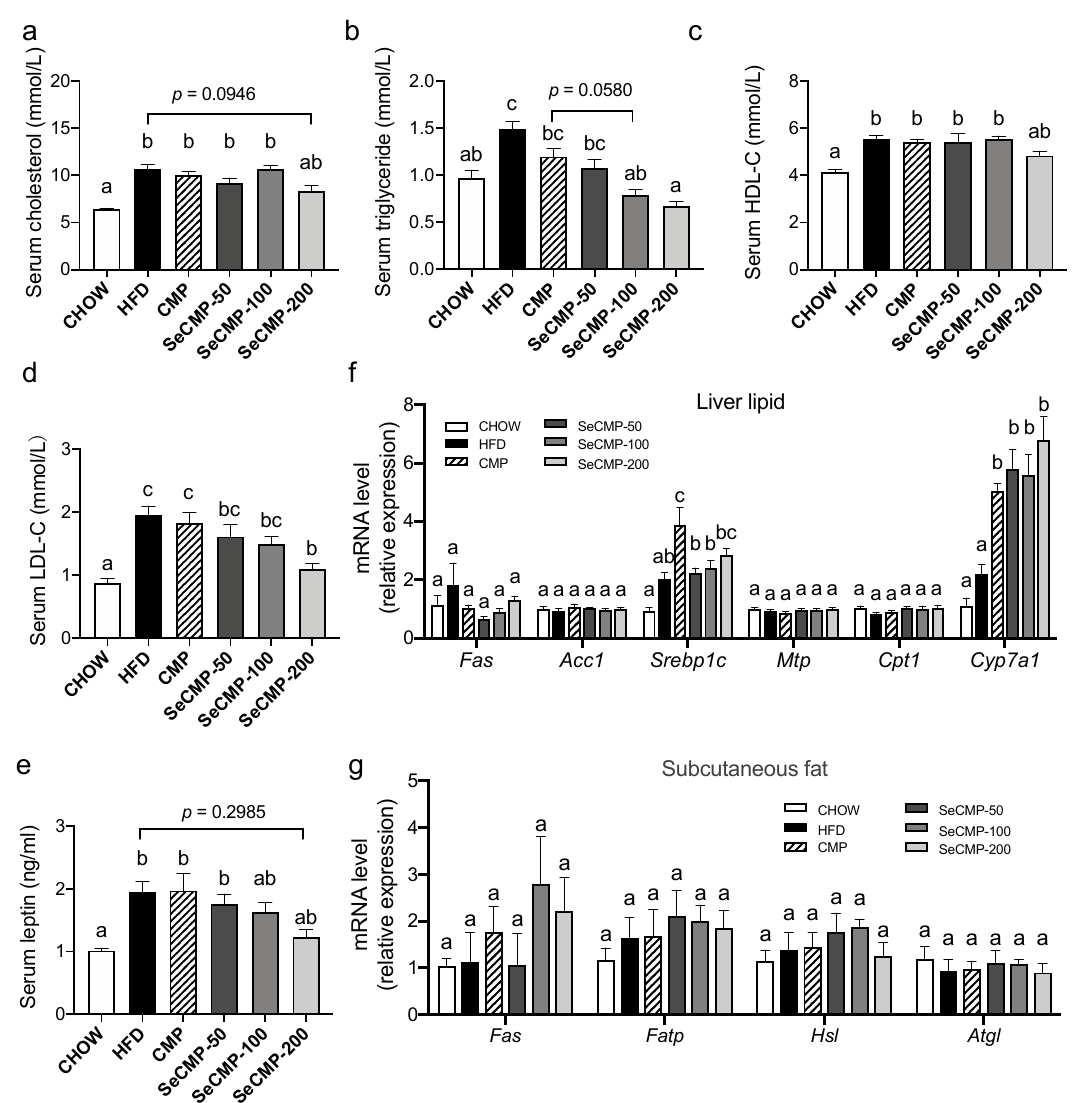
Figure 2. The modulation effect of selenium-rich C. militaris crude polysaccharides (SeCMP) and selenium-deficient C. militaris crude polysaccharides (CMP) on dyslipidemia in obesity mice. Serum cholesterol, triglycerides, HDL-C, LDL-C, and leptin are shown from ( a – e ). Q-PCR analysis was performed to quantify lipid absorption, distribution, and metabolism gene expression in ( f ) liver and ( g ) subcutaneous adipose tissue. The gene expression involved lipogenesis (fatty acid synthase, Fas; acetyl-CoA carboxylase, Acc1; sterol regulatory-element binding protein 1c, Srebp1c), lipid transport (microsomal triglyceride transfer protein, Mtp; fatty acid transport protein, Fatp), lipolysis (hormone-sensitive lipase, Hsl; adipose triglyceride lipase, Atgl; cholesterol 7 α -hydroxylase, Cyp7a1), or β -oxidation (carnitine palmitoyltransferase 1, Cpt1). Data represent mean ± SE (n = 8 mice/group). Superscript characters indicate significant variation among treatments in panel ( a – e ). Superscript characters in panel ( f , g ) indicate significant variation among treatments of each gene. CHOW: normal diet + sterile water; HFD: high-fat diet + sterile water; CMP: high-fat diet +100 mg/kg CMP; SeCMP-50: high-fat diet +50 mg/kg SeCMP; SeCMP-100: high-fat diet +100 mg/kg SeCMP; SeCMP-200: high-fat diet +200 mg/kg SeCMP.